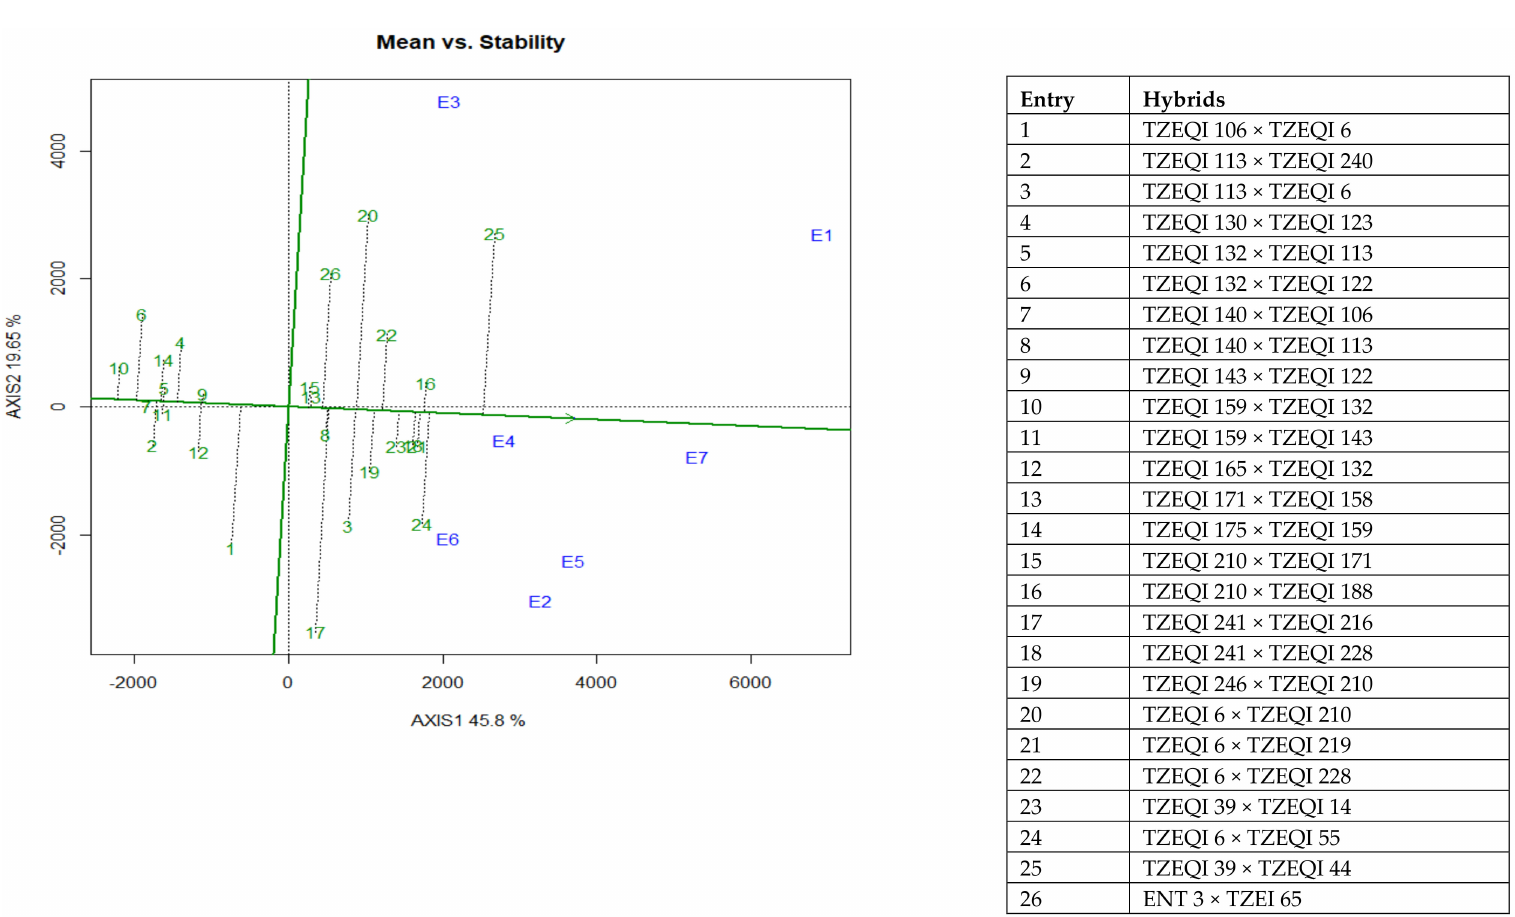
Figure 4. An entry/tester genotype main effect plus genotype by environment interaction biplot of grain yield of selected 22 early QPM hybrids plus checks based on CDHS and low-nitrogen base index evaluated across CDHS, low N and optimal environments from 2019 and 2021. E1 = Mokwa under low-nitrogen environment, 2019, E2 = Mokwa under low-nitrogen environment, 2020, E3= Mokwa under optimal envionment, 2019, E4 = Mokwa optimal environment, 2020, E5 = Kadawa optimal environment, 2020, E6 = Kadawa under CDHS environment, 2020, E7 = Kadawa under CDHS environment,